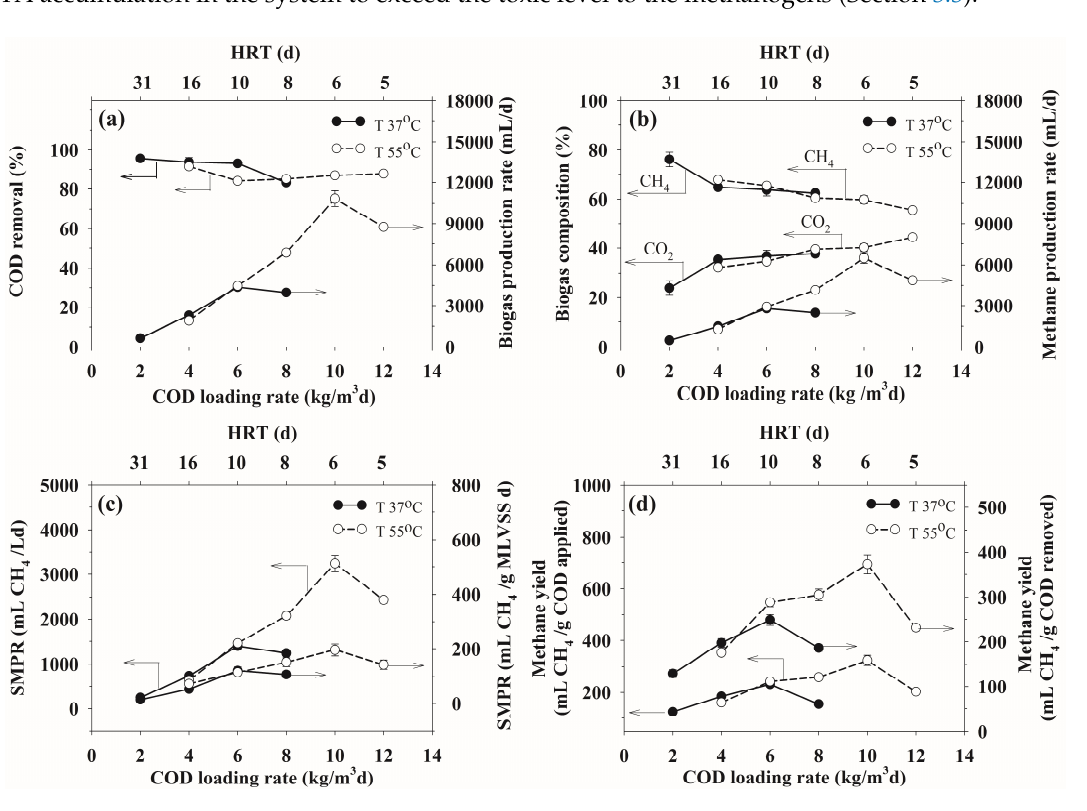
Figure 2. The effects of the chemical oxygen demand (COD) loading rate and hydraulic retention time (HRT) on the steady-state parameters; ( a ) COD removal and gas production rate; ( b ) gas composition and CH 4 production rate; ( c ) specific methane production rates (SMPRs); and, ( d ) CH 4 yields in the ASBR operated under a mesophilic (37 °C) or thermophilic (55 °C) temperature. Data are shown as the mean ± 1SD, derived from five independent repeats.